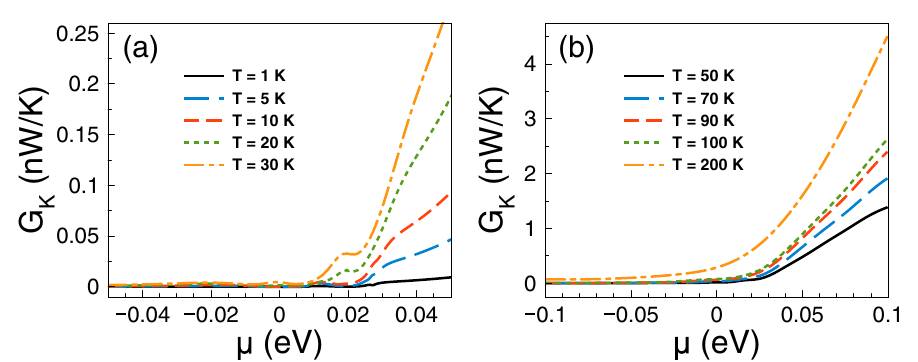
Figure 20. The same as Fig. 13, but for d B = d W = 10 nm. As in the other barrier cases, the ratio of G K to GT is not the Lorenz number. So, the contribution of S of magnitude lower than in strained single layer graphene 54 . The results of G K /( GT ) and S supplementary